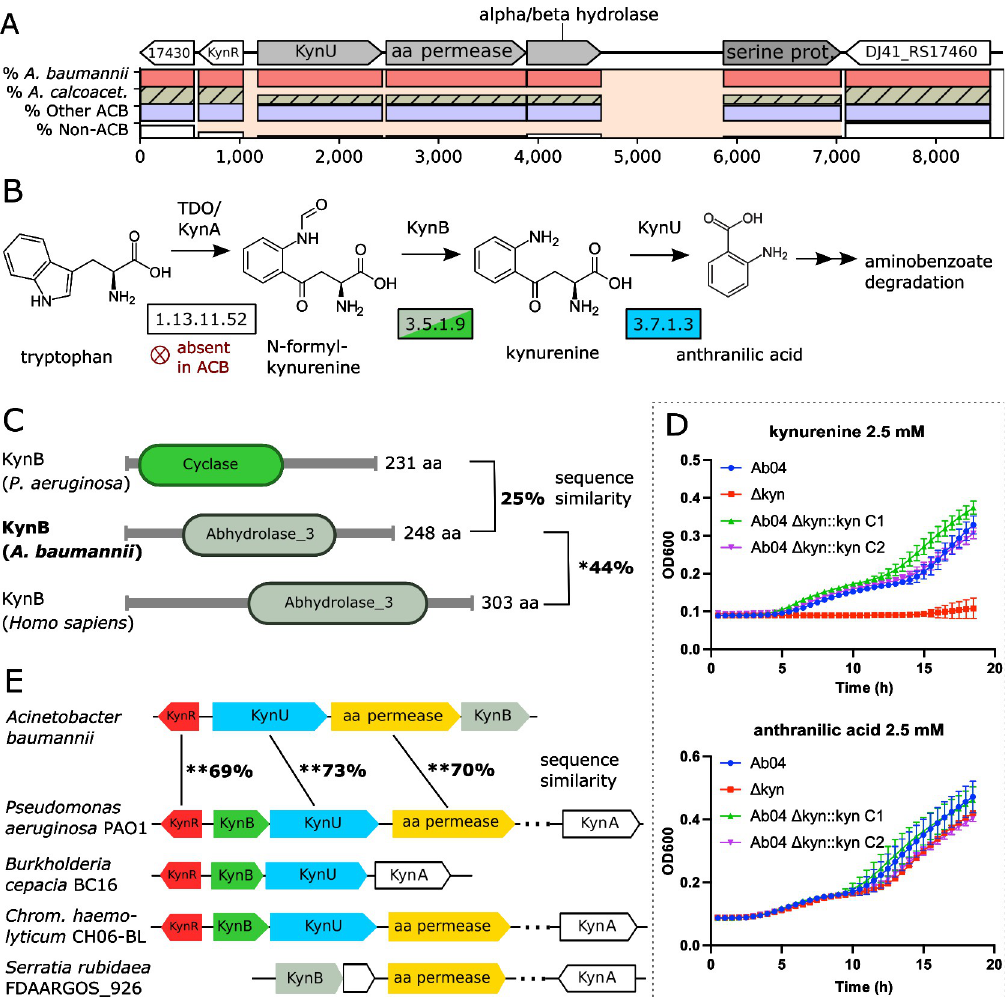
Fig 10. Evolutionary and functional characterization of the A. baumannii kynurenine pathway. (A) The locus of ESGC ACB 0452 in A. baumannii ATCC 19606. KynR—Lrp/AsnC family transcriptional regulator; KynU—kynurenine hydrolase; amino acid (aa) permease (uncharacterized); alpha/beta hydrolase (uncharacterized; putative kynB); serine proteinase. Cluster layout follows that of Fig 7. (B) The Kynurenine pathway of tryptophan degradation. EC numbers of the enzymes catalyzing the individual reactions are given in the boxes. KynB is represented in two versions in bacteria (see subfigure C), which are represented by different colors. (C) The alpha/beta hydrolase shares a significant sequence similarity and the presence of the Abhydrolase_3 Pfam domain (PF04199) with the human kynurenine formamidase (KynB or KFA) but not with KynB of P. aeruginosa, which instead harbors a Cyclase Pfam domain (PF04199) suggesting an independent evolutionary origin. (D) The kynurenine cluster is necessary and sufficient for growth on kynurenine but not on anthranilic acid. Growth of Ab04, Ab04 Δ kyn, and of two Ab04 Δ kyn::kyn strains (C1 and C2) on minimal medium supplemented with kynurenine (top) and anthranilate (bottom). (E) Phylogenetic profile of the A. baumannii Kyn cluster. Numbers between the corresponding genes in Ab ATCC 19606 and PA01 represent percent sequence similarity on the amino acid level. KynB of Ab ATCC 19606 and PAO1 are not significantly similar. The Kyn cluster is shared among many proteobacterial (opportunistic) pathogens where the Pseudomonas-type KynB is prevalent. The human-type KynB has homologs e.g., in Serratia (including S. rubideae). KynA is almost always encoded at a distant locus and entirely absent in